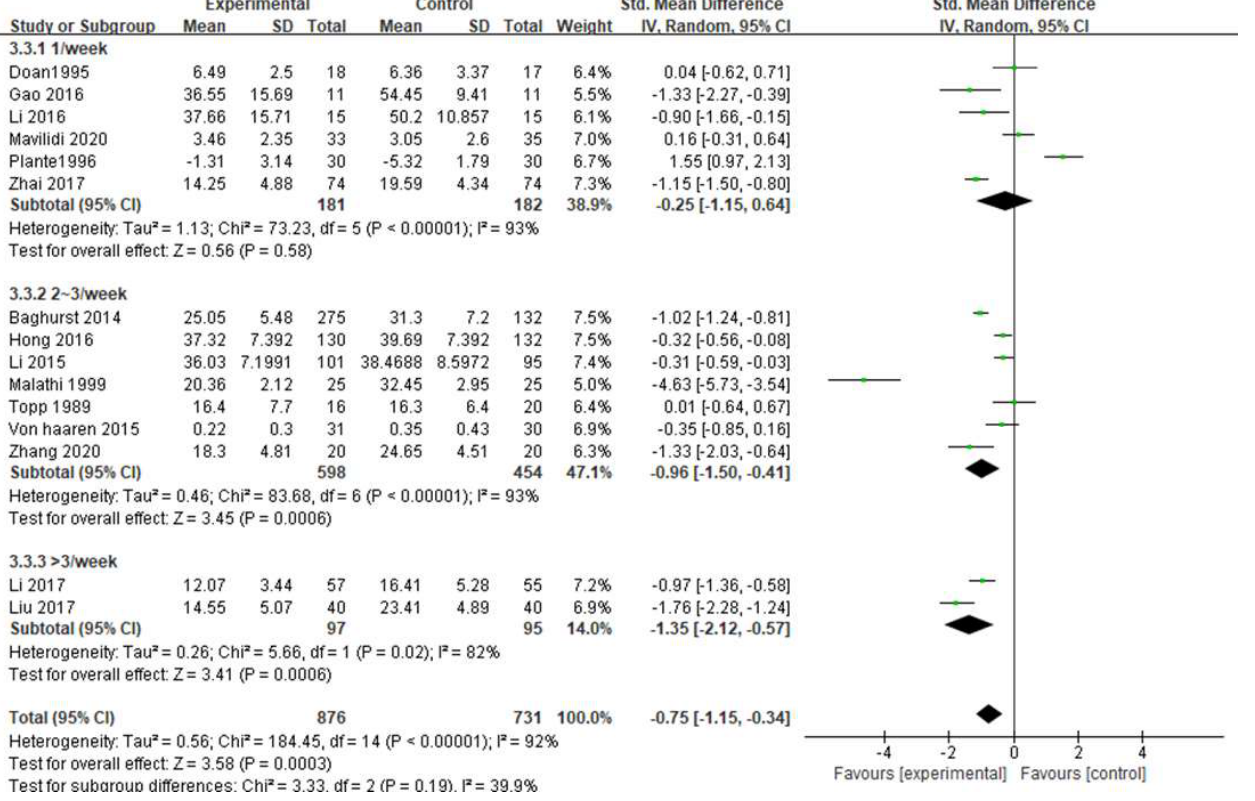
Figure 8. Subgroup analysis of exercise frequency